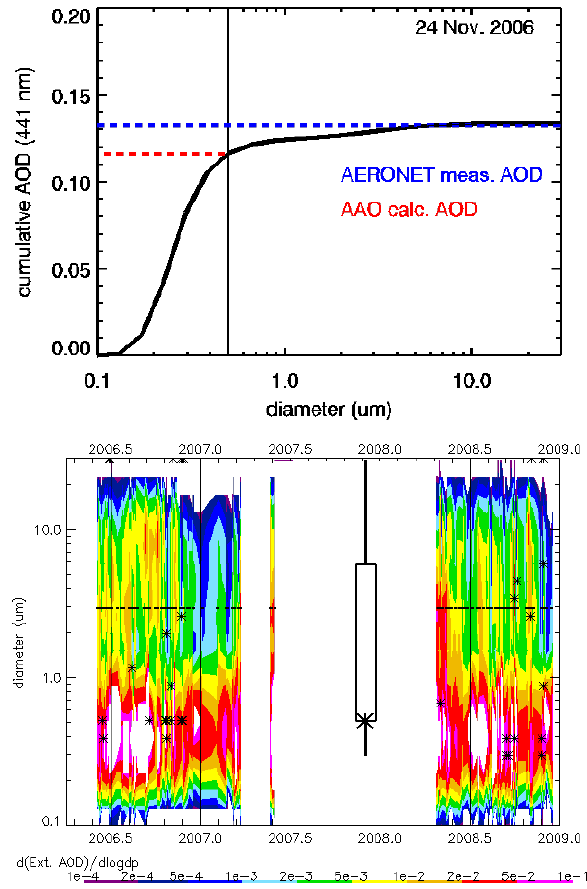
Fig. 14. (a) Cumulative AOD calculated from the AERONET mea- surements as a function of diameter for one AERONET size distri- bution retrieval. Vertical line represents the diameter where cumula- tive AERONET AOD matches AAO AOD; (b) Time series contour plot of AOD size distribution (dAOD/dlogD) as a function of di- ameter. The color contours are based on AERONET volume size distribution retrievals and assumed refractive index as described in text. The asterisks (*) represent the diameter where the AAO AOD matches the cumulative AOD derived from AERONET size distri- butions (assuming γ =0.67 for RH adjustment). The box-whisker diagram indicates statistics for the diameter for which the calculated cumulative AOD from the AERONET size distribution matches the AAO AOD. The ends of the whiskers are the 5th and 95th per- centiles, the ends of the box are the 25th and 75th percentiles and the asterisk represents the median value (same as 25th percentile).